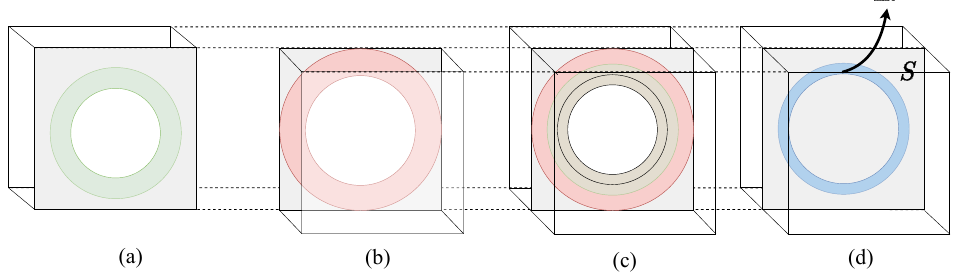
Figure 6. The overlap at the surface interface of two neighboring microstructures. ( a , b ) the sur- face area of two random neighboring microstructure at their interface plane, ( c ) overlaying of the two surfaces, ( d ) Intersection surface of two